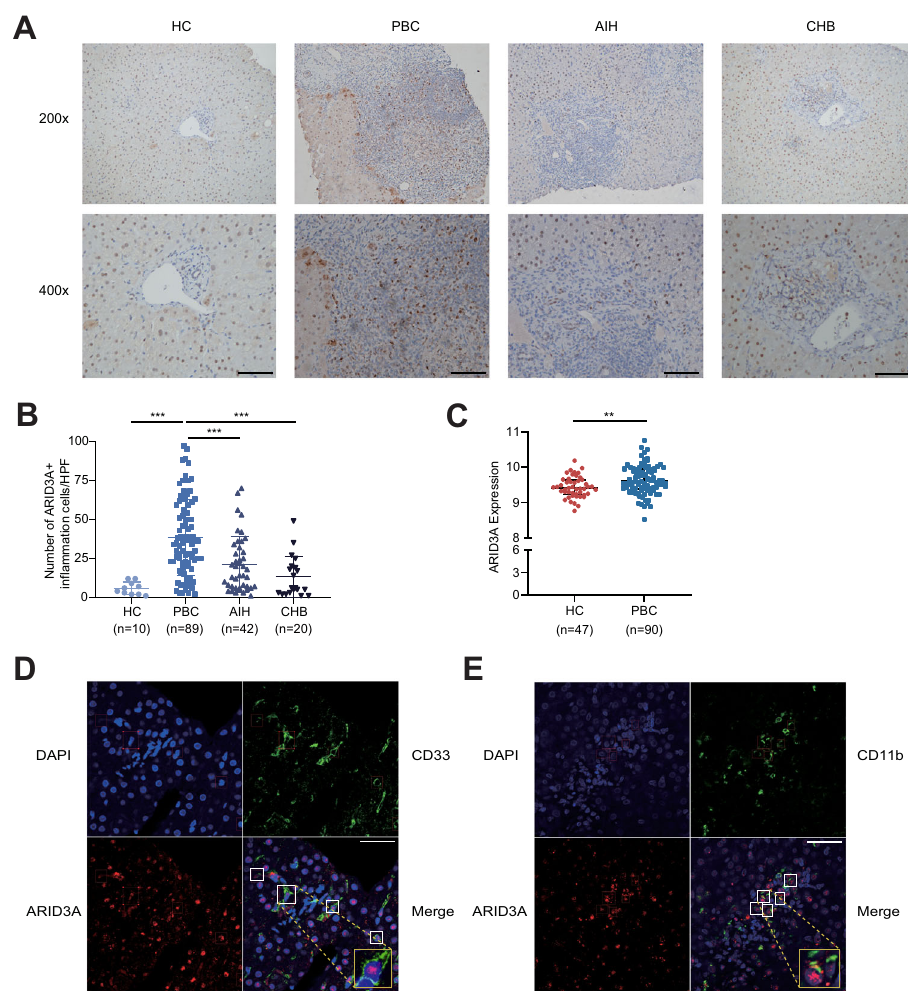
Fig. 6 | Increased ARID3A expression in PBC. A , B Representative immunohisto- chemical staining (x200; x400) and statistical analysis of ARID3A in HC ( n =10), PBC( n =89),AIH( n =42)andCHB( n =20)patients. C Increased ARID3A expression in whole blood from PBC patients (HC, n =47; PBC, n =90). D Representative confocalstainingofCD33(ingreen),ARID3A(inred)andDAPI(fornucleiinblue)in the PBC liver ( n =10). E Representative confocal staining of CD11b (in green),